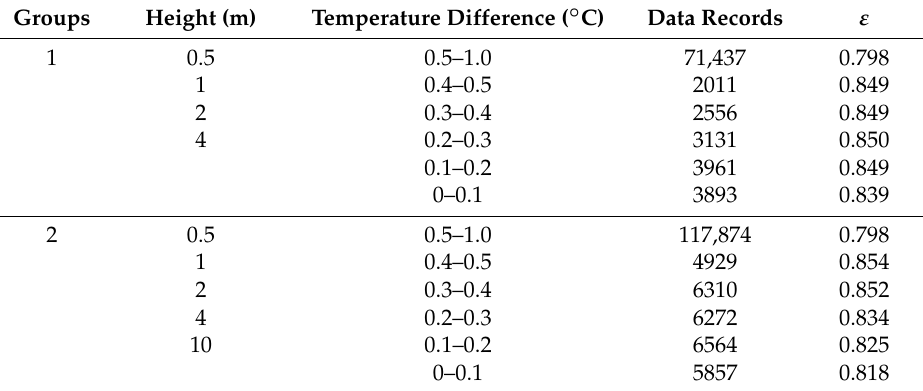
Table 5. Estimates of ε according to the temperature gradients in near zero